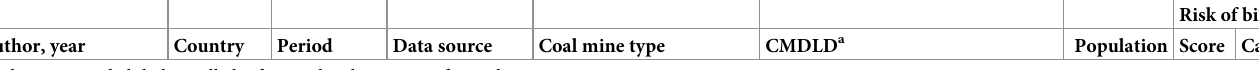
Table 2. Summary of included studies in systematic